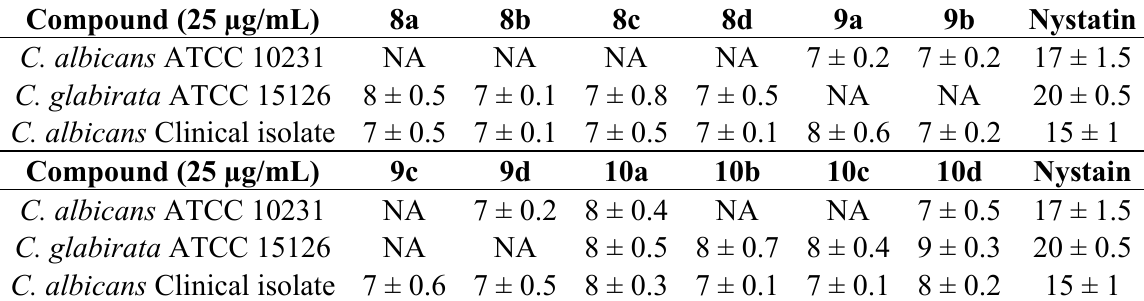
Table 1. Antifungal activity of compounds ( 8 – 10 ) at 25 